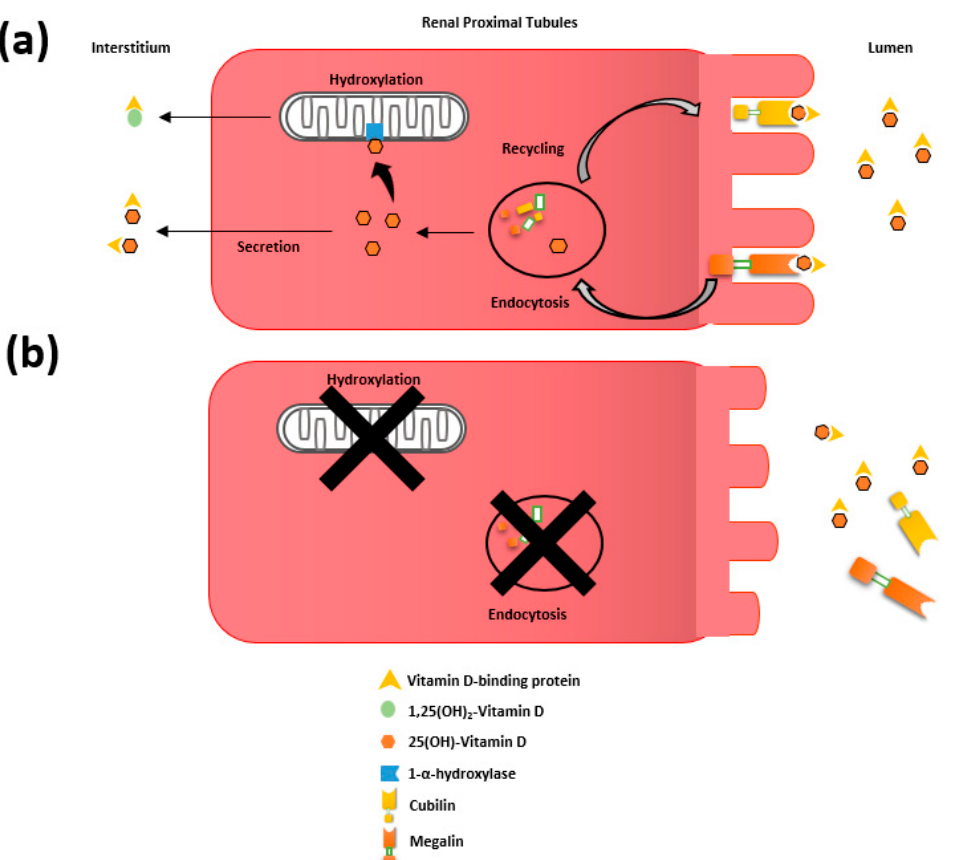
Figure 2. Representation of the tandem function of megalin and cubilin in renal uptake of 25(OH)-VD. ( a ) Filtered complexes of vitamin D binding protein (VDBP) and 25(OH)-VD are endocytosed by the proximal tubular epithelium via an endocytic receptor-mediated pathway recognizing VDBP. The VDBP is degraded in the lysosomes releasing 25(OH)-VD which is either secreted or hydroxylated in the mitochondria to 1,25(OH) 2 -VD. Both 25(OH)-VD and 1,25(OH) 2 -VD reenter the circulation bound to VDBP. ( b ) Postulated megalin and cubilin shedding in chronic kidney disease (CKD) perpetuating vitamin D deficiency (VDD) with subsequent lower 25(OH)-VD reuptake and intracrine 1,25(OH) 2 -VD production in the renal proximal